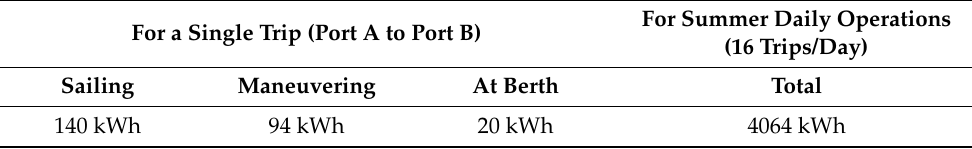
Table 3. Ship energy consumption for a single trip and throughout the entire day in summer.